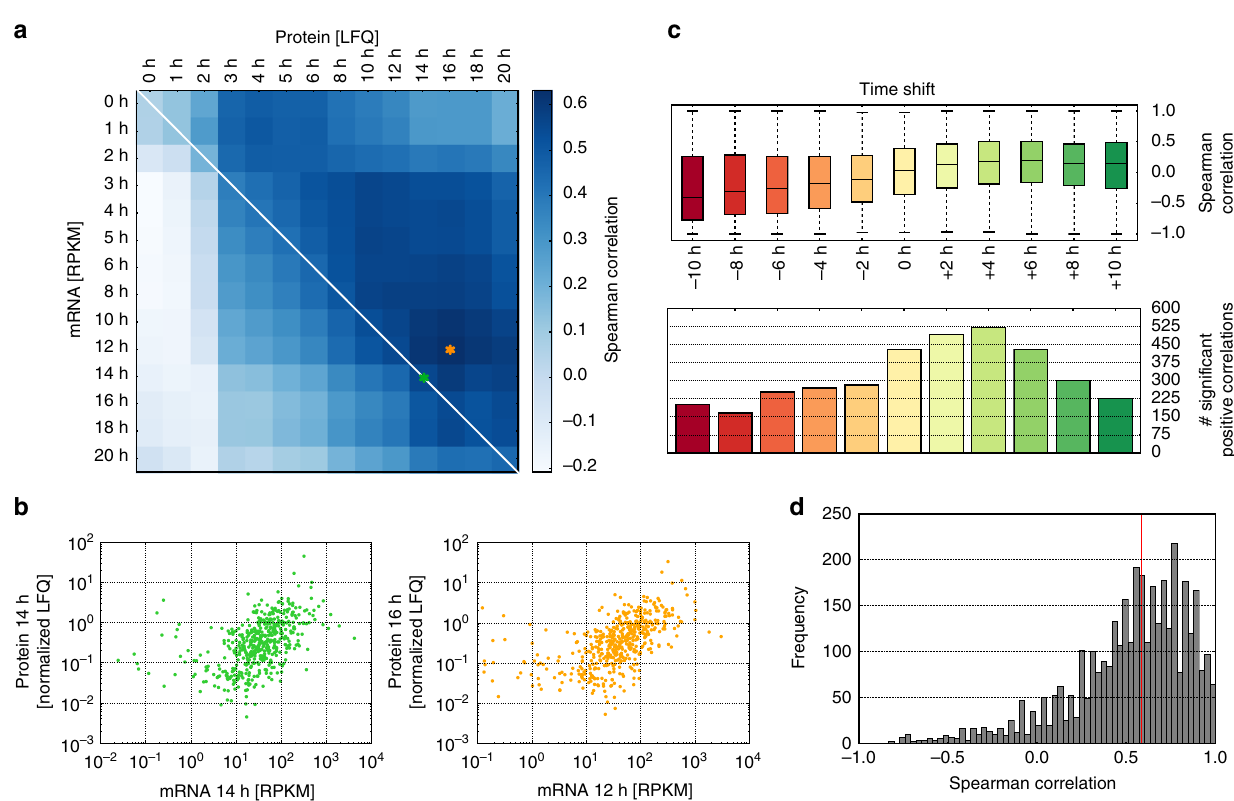
Fig. 2 Limited correlation between mRNA and protein levels. a Global RNA − protein correlation across all samples. Heatmap of Spearman correlation coef fi cients between protein abundance ( x -axis; quanti fi ed using MaxLFQ), and mRNA levels ( y -axis; expressed as RPKM values), at the same (diagonal) or shifted (off-diagonal) time points of embryonic development. Only the top 500 proteins showing largest absolute fold-changes compared to the 0 h time point were considered. Green and orange stars indicate maximum correlation between same and shifted time points, respectively. Corresponding scatter plots are shown in ( b ). b Maximum global RNA − protein correlation. Scatter plots showing correlation of mRNA (RPKM) and protein (LFQ) levels at 14 h (left, ρ = 0.56), or between mRNA at 12 h and protein at 16 h (right, ρ = 0.63). Chosen time points correspond to the orange and green stars marked in ( a ). c Local correlations relating the mRNA and protein time courses of individual genes were calculated using the Spearman correlation coef fi cient. Boxplots indicate the distribution of Spearman correlation coef fi cients for all 3761 mRNA − protein pairs (black line: median; boxes: quartiles; whiskers: 95- percentile) (upper panel). Time shifts between mRNA and protein dynamics were introduced by adding a constant to the time axis of the protein (0 h: no shift). Positive and negative values re fl ect that protein lags behind or is advanced relative to its mRNA, respectively. Number of mRNA − protein pairs with a signi fi cant (Student ’ s t test, two-sided, p < 0.05), positive correlation for each time shift (bottom panel). d Distribution of maximum Spearman correlation coef fi cients across all time shifts. For each individual mRNA − protein pair ( n = 3761), the maximum correlation between the mRNA and protein time courses at any time shift between 0 h and + 10 h was determined and considered in this histogram. The red line indicates the median of all